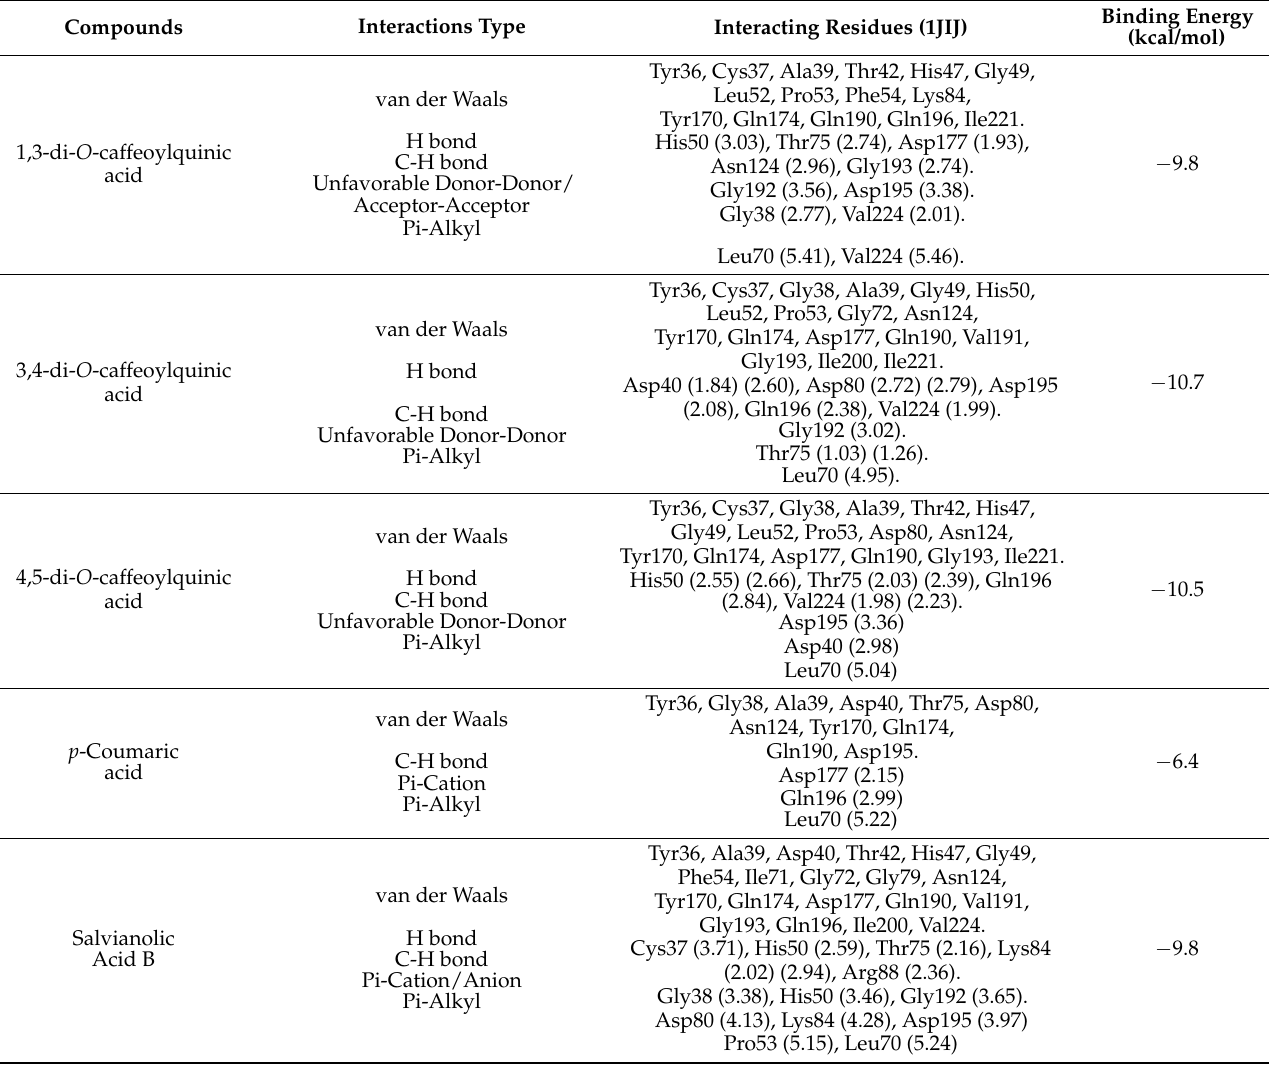
Table 5. Major phytochemicals, with the top two having the lowest binding energies with their interaction residues with TyrRS from S. aureus (PDB: